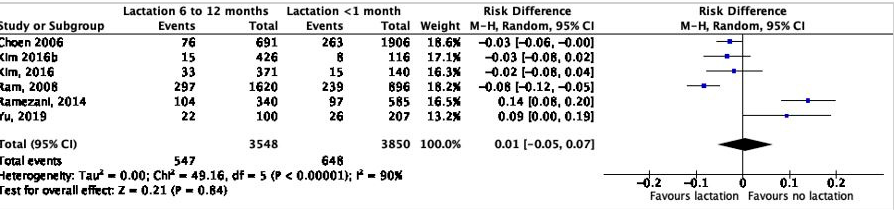
Figure 3. Forest Figure 3. Forest plot.